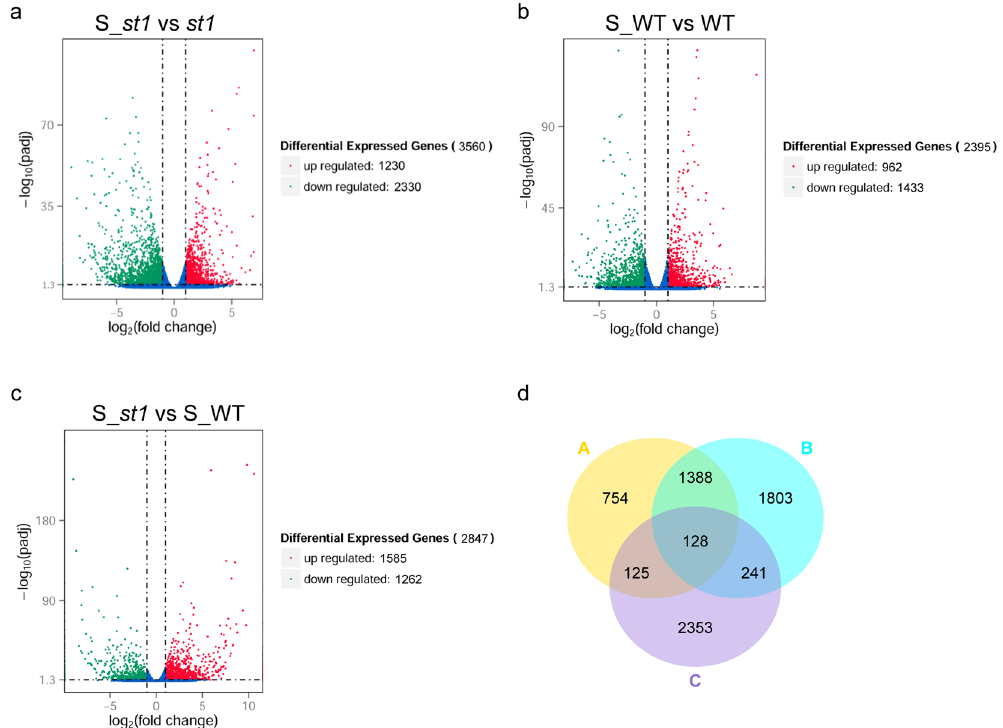
Figure 4. Volcano plots and Venn diagrams of DEGs. ( a – c ) DEGs between salt-treated st1 and st1 (S_ st1 vs st1 , a ), salt-treated WT and WT (S_WT vs WT, b ), salt-treated st1 and salt-treated WT (S_ st1 vs S_WT, c ) displayed by volcano plots. The abscissa shows the fold change difference in the expression of genes in different comparison groups, and the vertical coordinates indicate the adjusted P -values for the differences in expression. Genes without significant differences are indicated by blue dots. The up-regulated genes are represented by red dots, and the down-regulated genes are represented by green dots. ( d ) Venn diagrams illustrating the overlap in DEGs between WT and st1 in response to salinity stress. The numbers in each circle (Circle A, S_WT vs WT; Circle B, S_ st1 vs st1 ; Circle C, S_ st1 vs S_WT) indicate the total number of different genes in each comparison group, and the number in the overlapping areas is the number of shared genes between two comparison